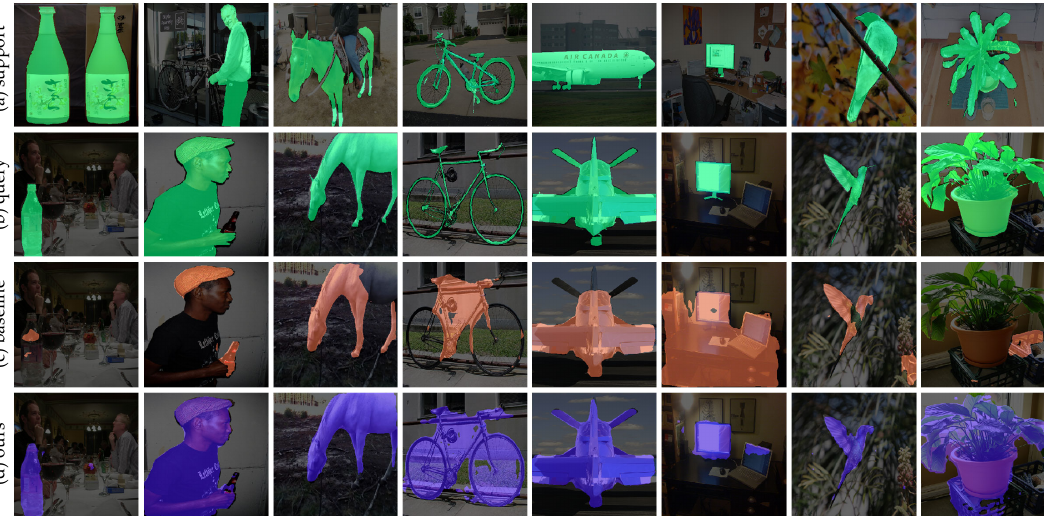
Figure 4. Qualitative results of our approach on Pascal-5 i in 1-shot setting. From top to bottom: ( a ) support images with ground truth masks, ( b ) query images with ground truth masks, ( c ) predic- tions of baseline, ( d ) predictions of our